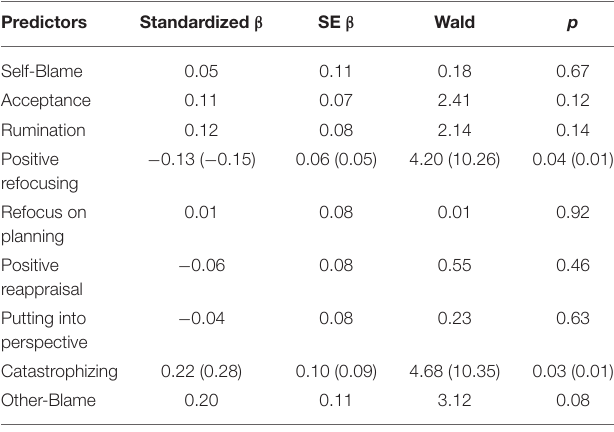
TABLE 6 | Identification of Cognitive Emotion Regulation Strategies Discriminating Subgroup Membership (FMS with vs. without Depression): Initial Logistic Regression Model and Final Logistic Regression Model (between